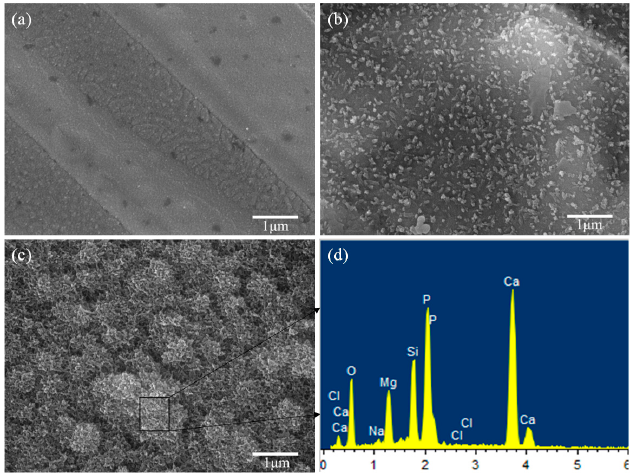
Figure 7. Morphologies of the scaffolds with: ( a ) 0 wt %; ( b ) 10 wt %; ( c ) 20 wt % CaSiO 3 after immersion in simulated body fluid (SBF) for 14 days; and ( d ) EDS spectra at the location indicated with the square.